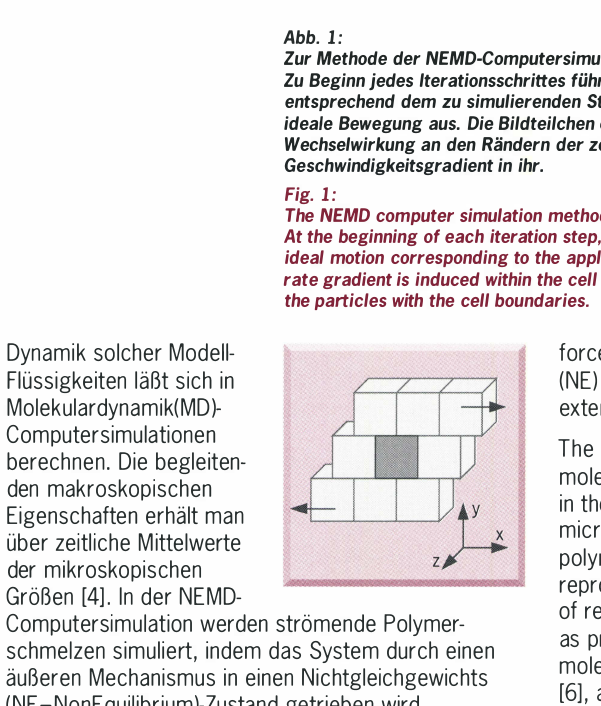
Fig.l: The NEMD computer simulation method At the beginning of each iteration step, the particles are set in ideal motion corresponding to the applied flow profile. A shear rate gradient is induced within the cell through interactions of the particles with the cell